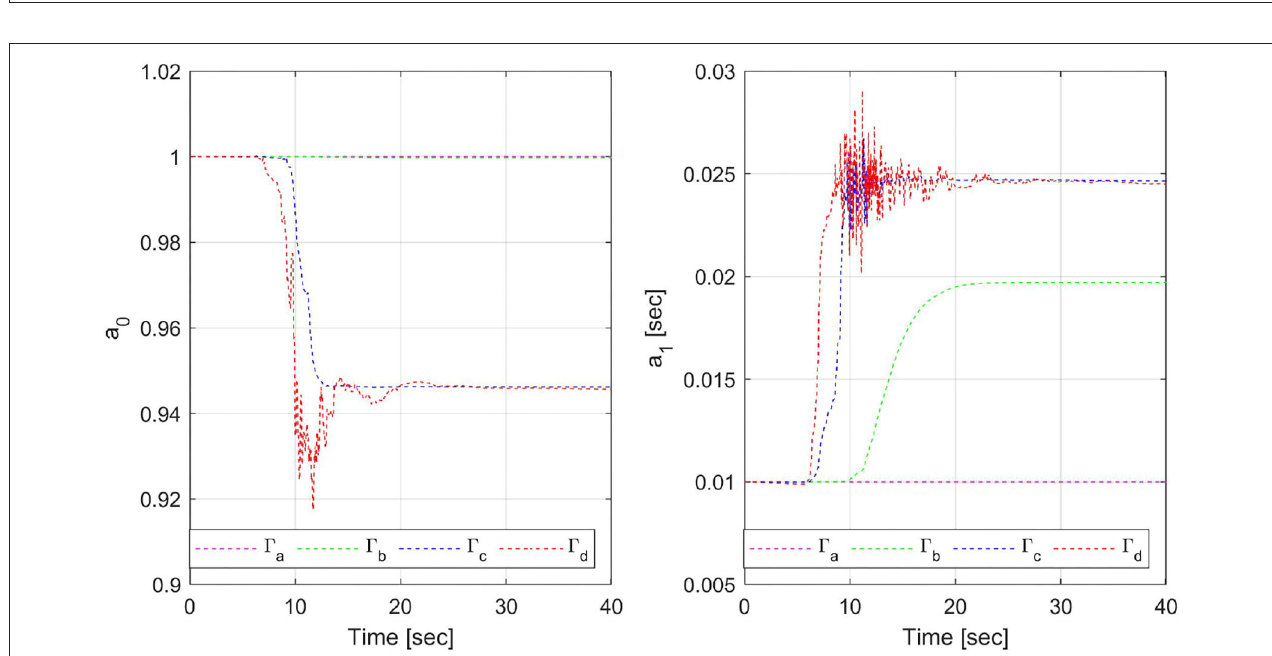
FIGURE 12 | Adaptation of control parameters a 0 and a 1 for different adaptive gains.